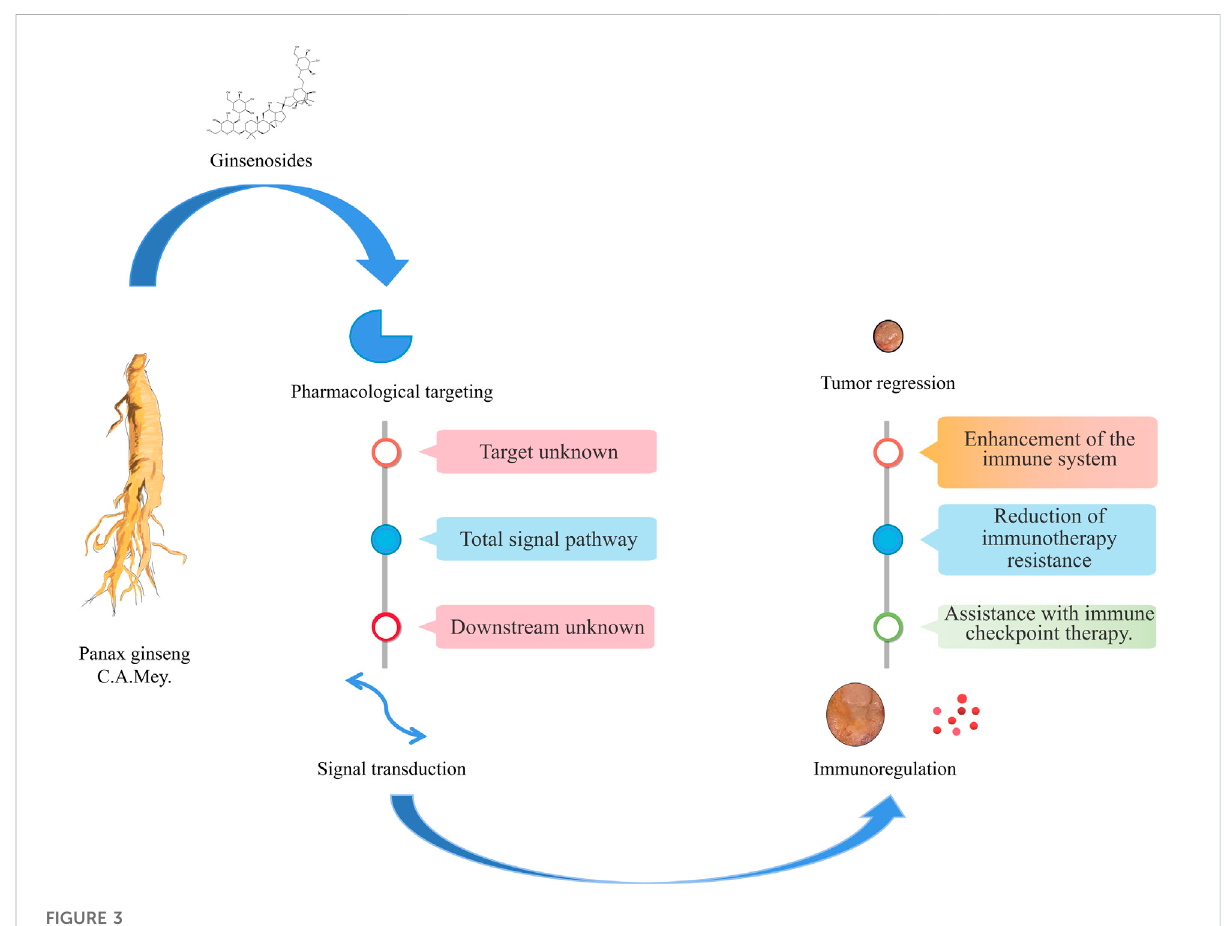
FIGURE 3 Ginsenosides in immunotherapy of gastrointestinal